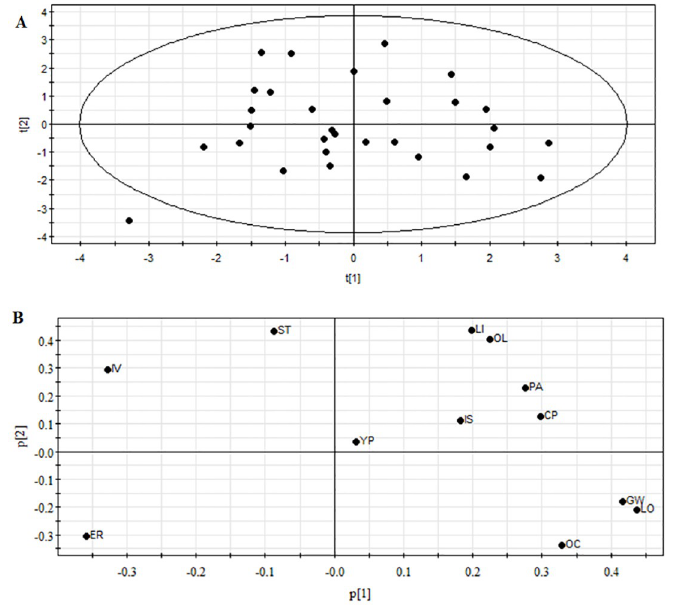
Fig 3. Principal component analyses (PCA) of varieties (A) and traits